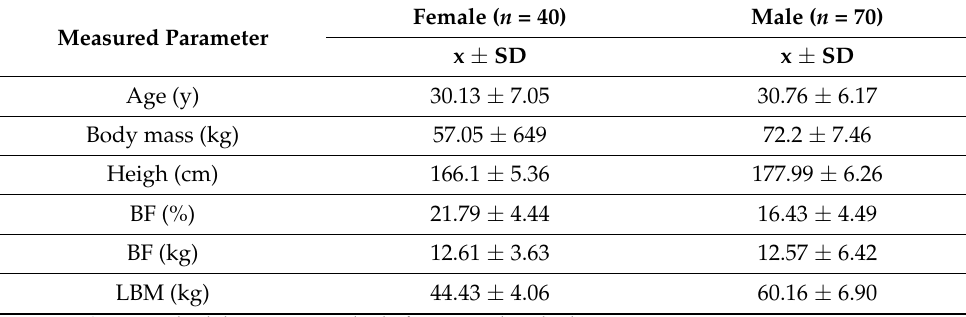
Table 1. Anthropometric measurements of the study